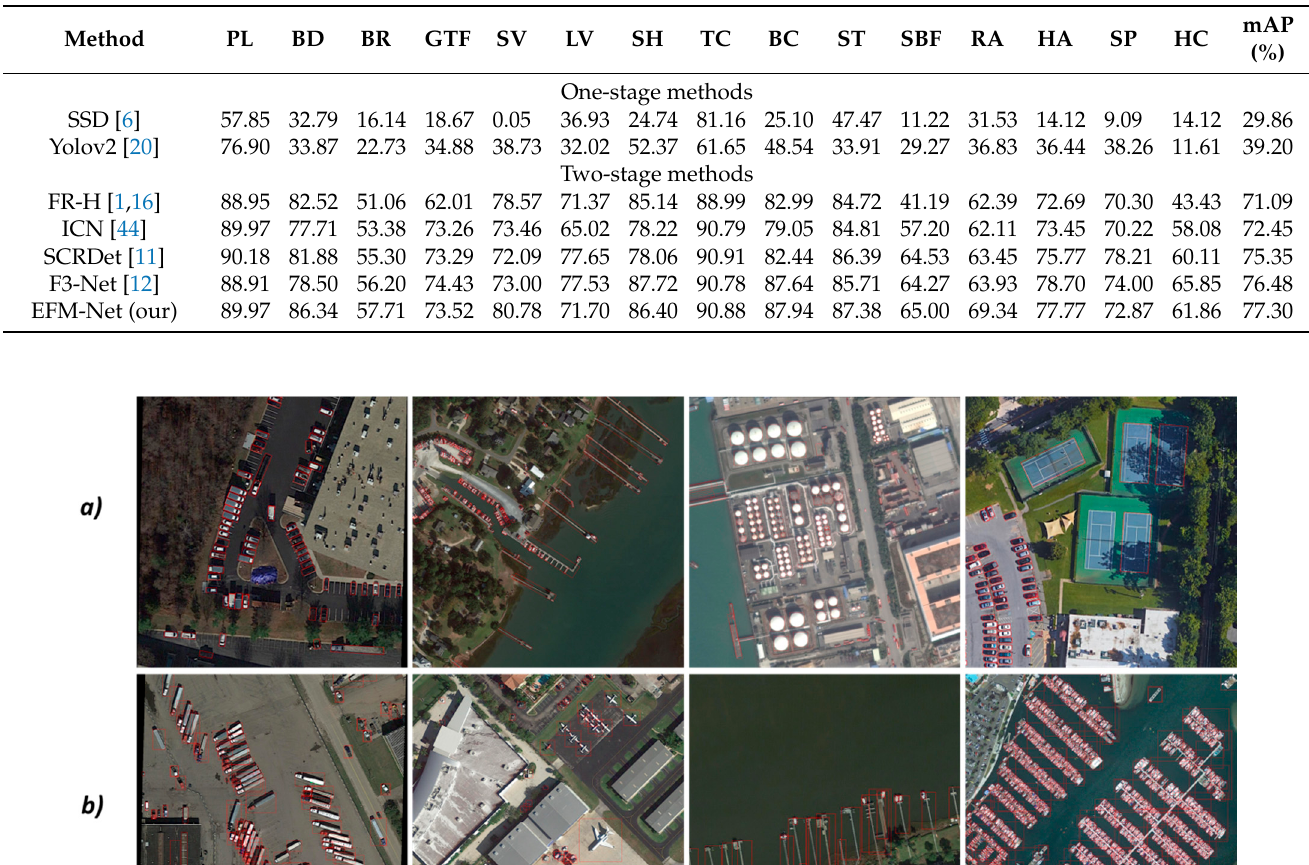
Table 3. Performance evaluation of the HBB task on the DOTA dataset.